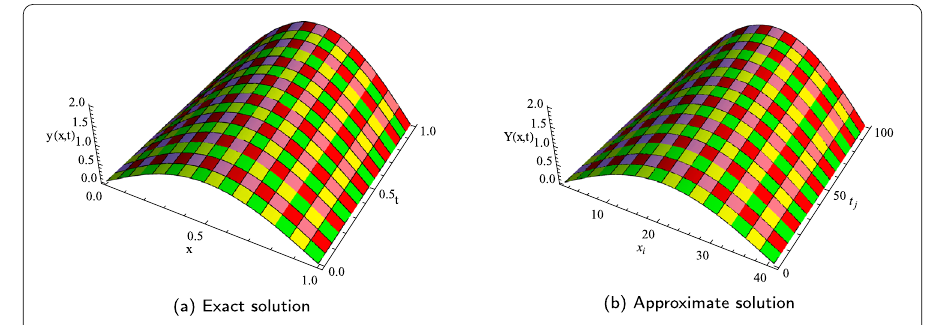
Figure 5 Exact and approximate solution for Problem 3 when γ = 0.5, n = 40, and (cid:12) t = 0.01